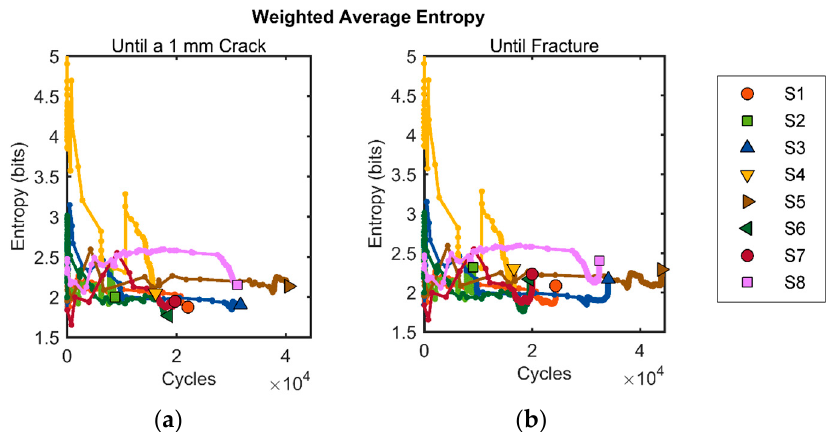
Figure 14. Weighted average entropy trends versus fatigue cycles through two damage levels: ( a ) weighted average entropy until a 1-mm crack; and ( b ) weighted average entropy until fracture.